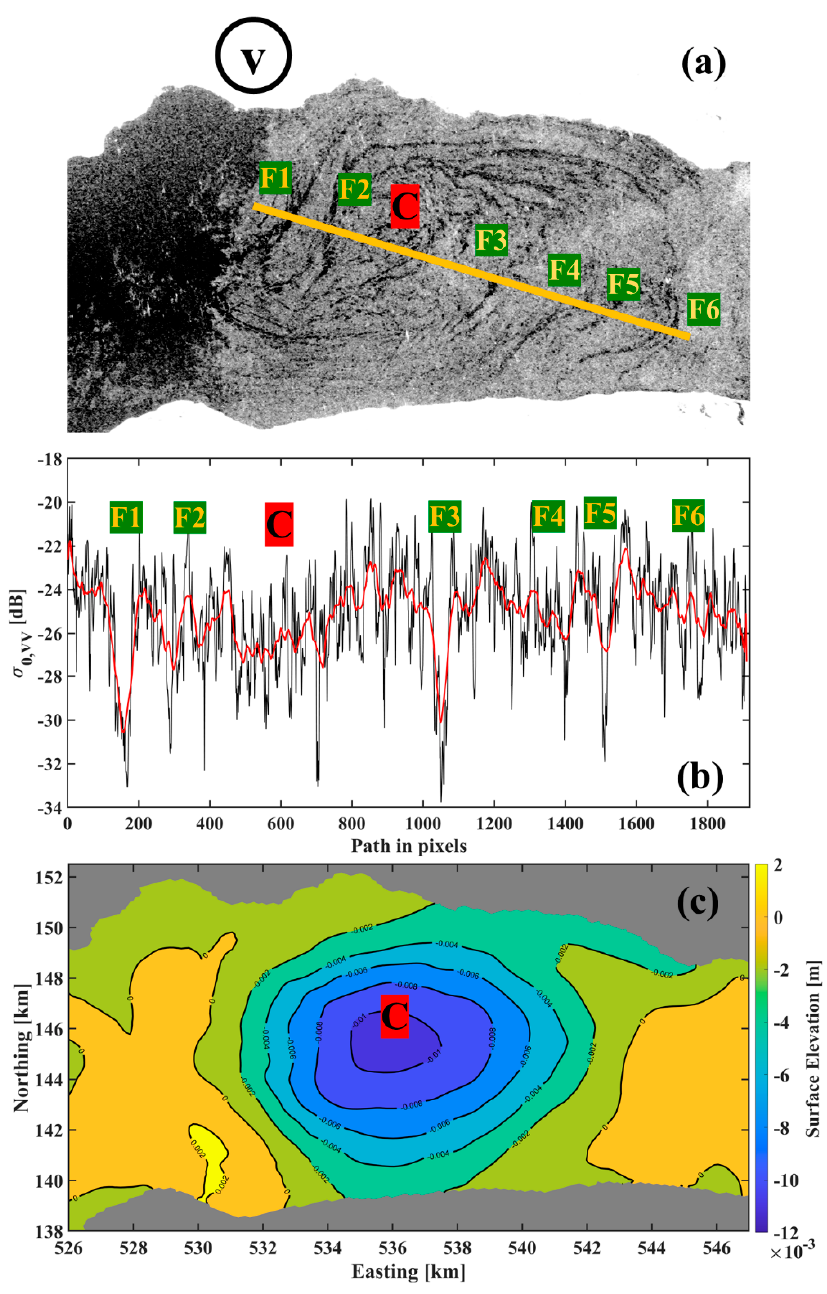
Figure 10. ( a ) Subset of a Sentinel-1B SAR-C image acquired on 21 July 2018 at 17:31 UTC. Filaments are marked by F along the orange transect; C: center of the gyre. ( b ) Variability of the raw NRCS data ( σ 0, VV ) and the moving average (red line) along the orange transect shown in ( a ). ( c ) Simulated water surface elevation (given as the offset from the average water level) for 21 July 2018 at 18:00 UTC for the area shown in ( a ). Colorbar legend: range of surface elevation. V: reference point marked in Figure 1.